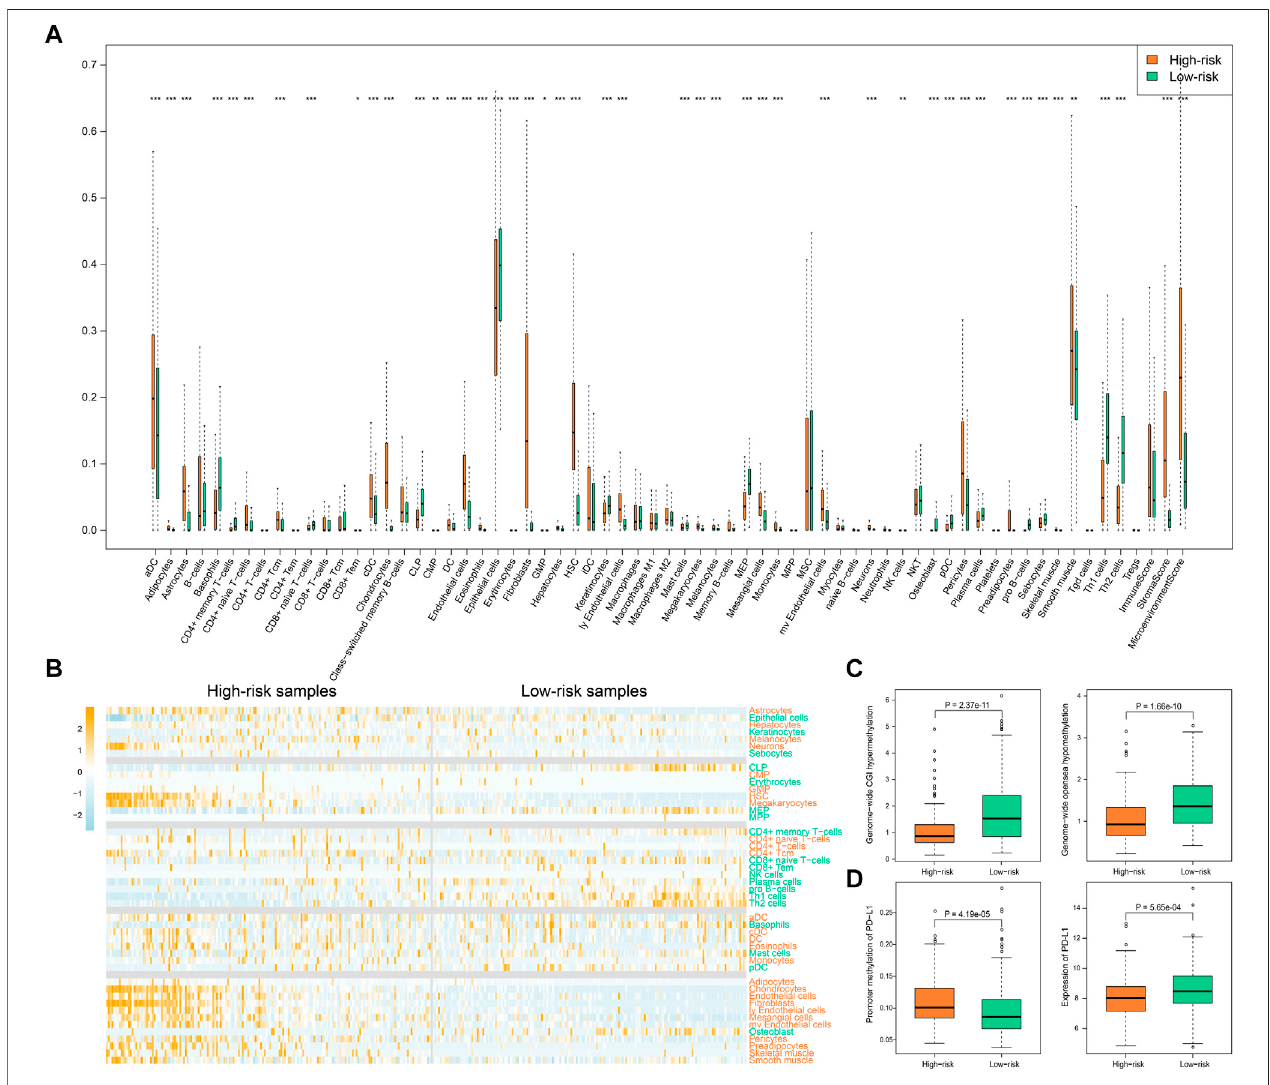
FIGURE 7 | Immune-related score by “ xCell ” . (A) The in fi ltration of immune and stromal cell types as well as the immune-related scores in high-risk and low-risk samples. p values less than 0.05, 0.01, and 0.001 are marked with “ * ” , “ ** ” , and “ *** ” . (B) The heatmap of in fi ltration degree of those immune and stromal cell types with signi fi cantlydifferentin fi ltrationinhigh-andlow-risksamples.Celltypesmarkedwithorangecolorrepresenthigherin fi ltrationinhigh-risksampleswhilecelltypesmarked with green color represent higher in fi ltration in low-risk samples. Samples are sorted by SSA-NHEJ score. (C) Genome-wide hypermethylation in CGI regions and hypomethylation in open sea regions. (D) Promoter methylation and expression of PD-L1 in high-risk and low-risk samples. p values were evaluated by Wilcoxon test.